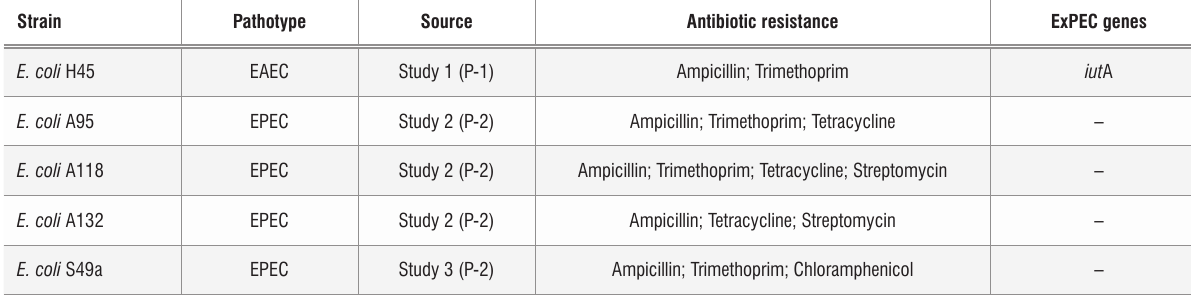
Antibiotic resistance profiles and presence of ExPEC genes in the InPEC strains Strain Pathotype